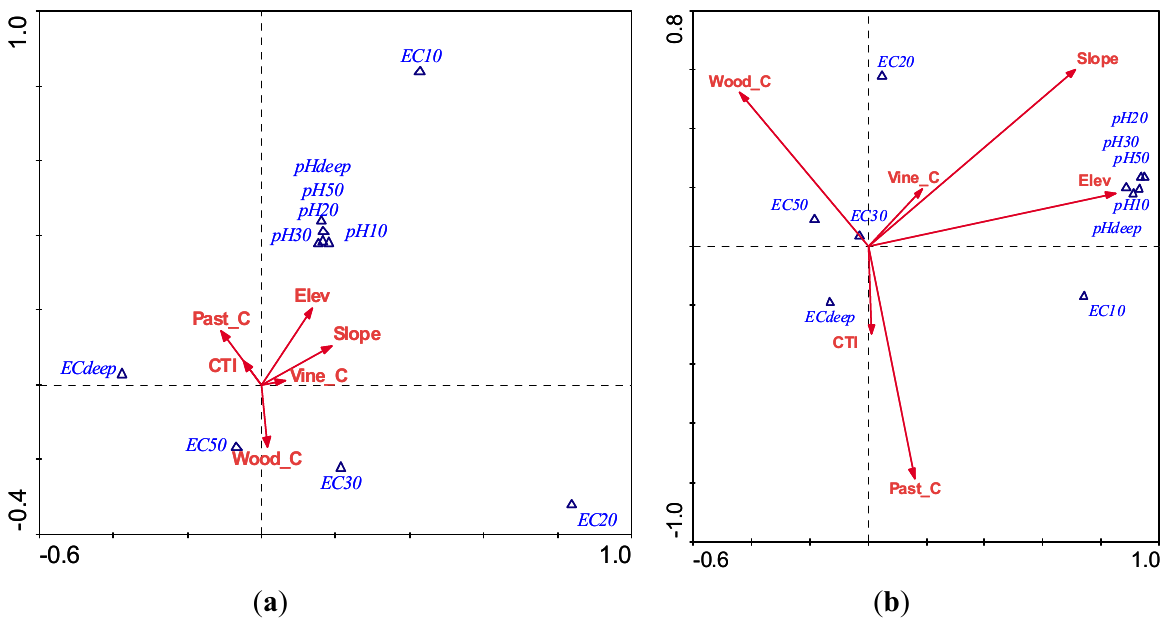
Figure 5. Biplots from ( a ) Correspondence analysis and ( b ) Canonical correspondence analysis. Note that: Wood_C = Woodland consistency, Past_C = Pasture/scrubland consistency, Vine_C = Vineyard Consistency, Elev = Elevation, CTI = Compound topographic index, pH10 = pH of soil at a depth of 0–10 cm, pH20 = pH of soil at a